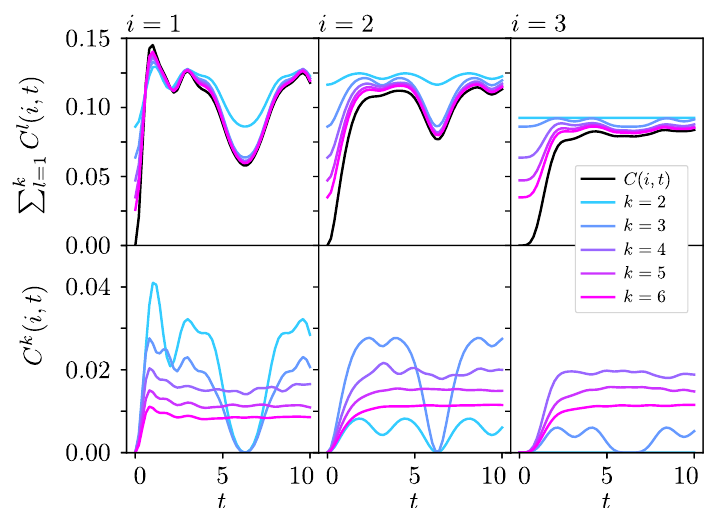
Figure 9: Contribution of the different k -triplet sectors for C ( i , t ) . The upper row (cid:80) k C l ( i , t ) by respecting triplet sectors up to shows the OTOC approximations l = 1 length k together with the numerical obtained OTOCs (black) for L = 12 rungs. The bottom row shows the isolated contributions C k ( i , t ) of the different sector lengths.